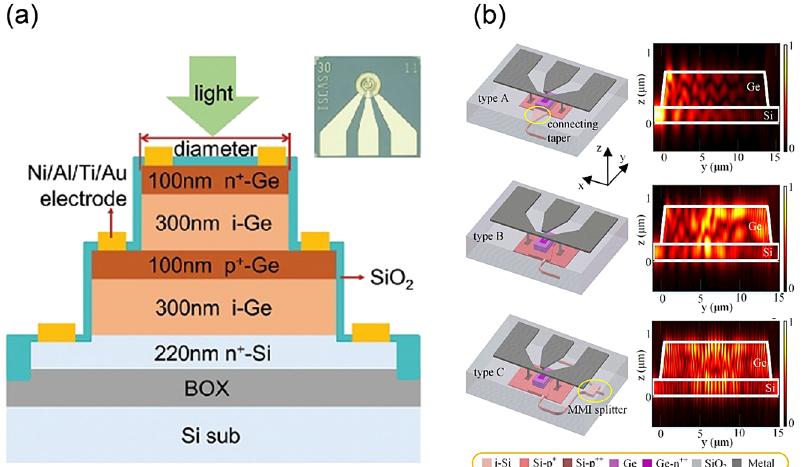
Figure 8: High-power Si – Ge photodetectors. (a) Back-to-back top-illuminated dual- absorption photodiode. (b) Photodetector based on a light field